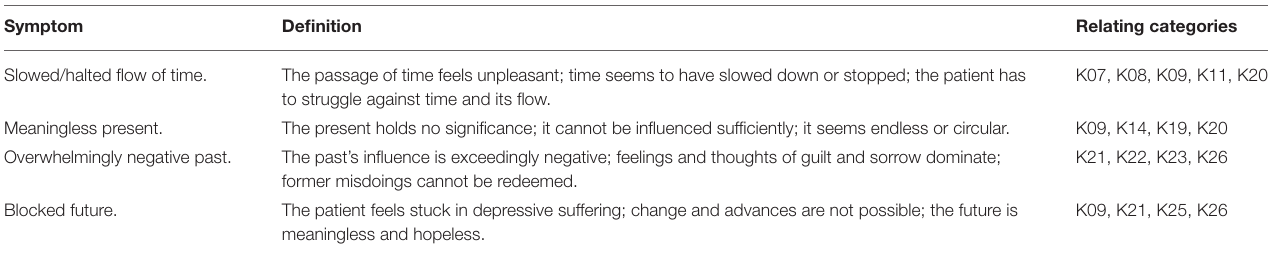
TABLE 4 | Disturbance of Lived Time in depression. Symptom Definition Slowed/halted flow of